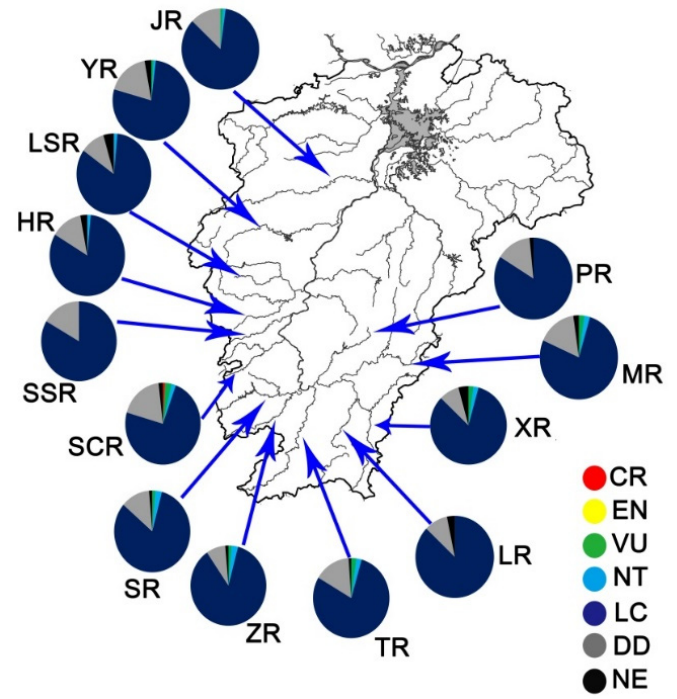
Figure 5. Fish species composition according to threatened status based on Chinese Red-list results in river basins of the Gan River Basin in the current period. Abbreviations include CR, Critically Endangered; EN, Endangered; VU, Vulnerable; NT, Near Threatened; LC, Least Concern; DD, Data Deficient; and NE, Not evaluated. River codes are the same as in Table 1.